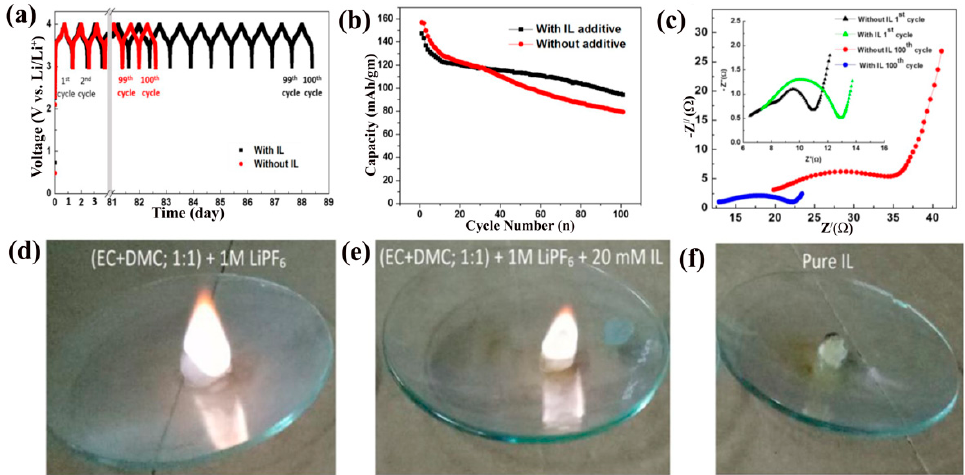
Figure 8. ( a ) Galvanostatic charging–discharging (GCD) at a constant current (10 mA/g) of the cells with IL (black color) as additive and without IL (red color). The GCD cycles were interrupted when the cell voltage exceeded 4.0 V or dropped below 3.0, respectively. Notice the break plot from 3 to 81 days, ( b ) discharge capacitance performances of the cell in electrolyte without (red) and with IL (black), ( c ) electrochemical impedance response after the 1st and 100th cycle of the cell for electrolyte without and with IL additive, flammability test for ( d ) conventional electrolyte, ( e ) conventional electrolyte with IL, ( f ) and pure IL, copyright; Reprinted with permission from Ref. [96]. Copyright 2020 Springer